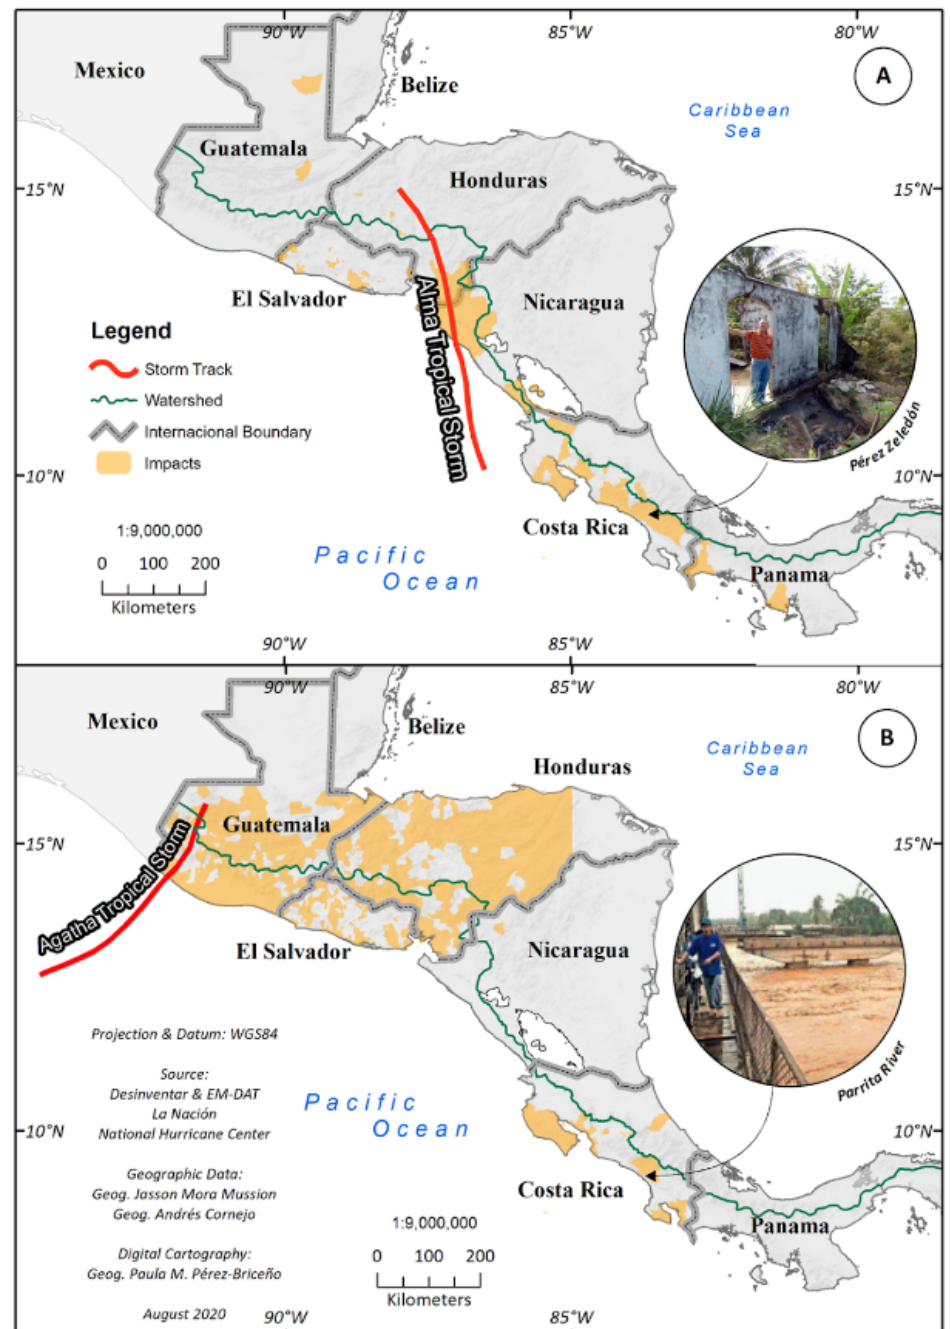
Figure A2. Same as Figure A1, but for the